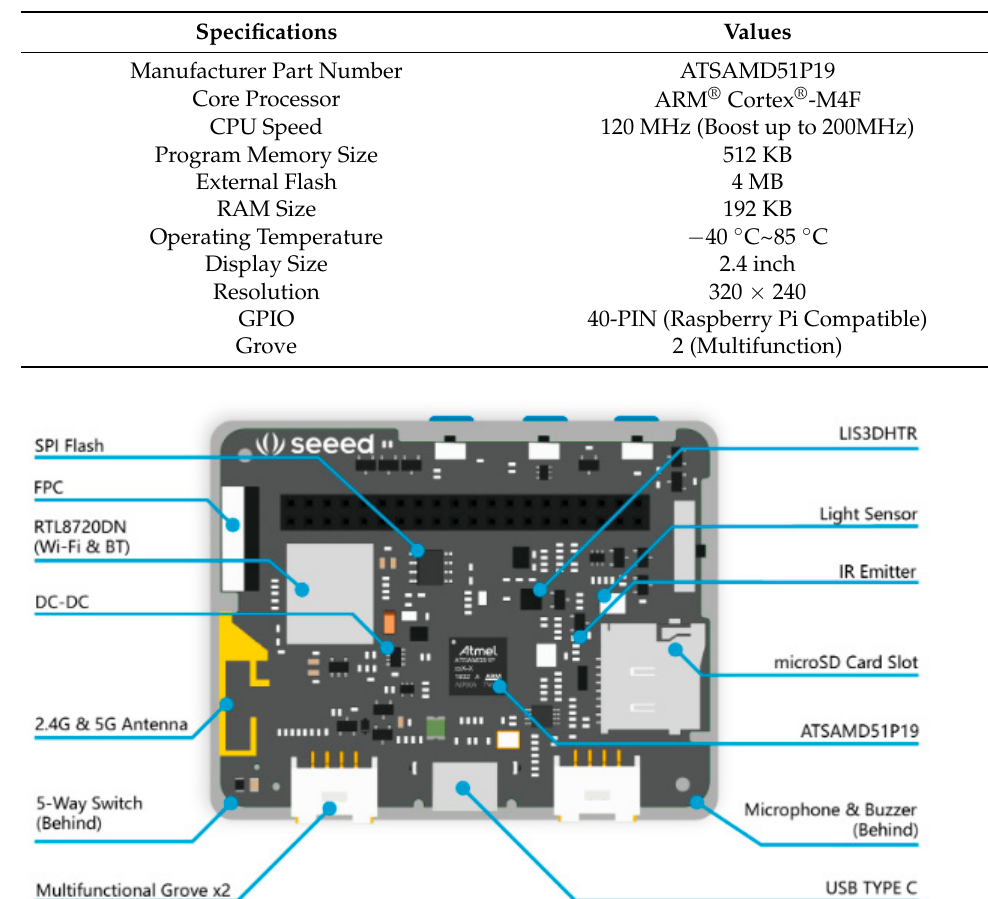
Figure 5. Wio terminal as the second RTU .